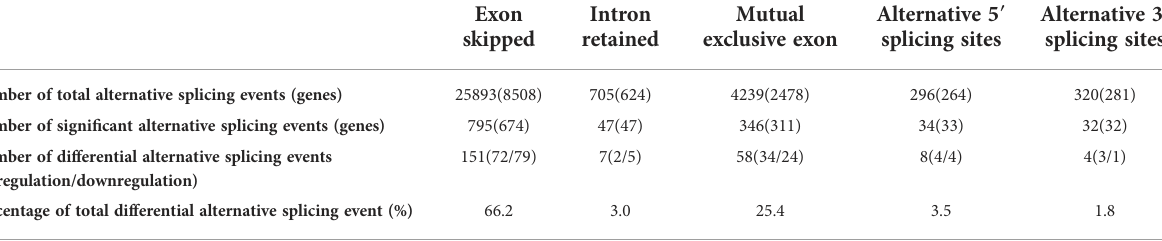
TABLE 1 Differential alternative splicing events between M. bovis -infected EBL cells with siANXA2 and